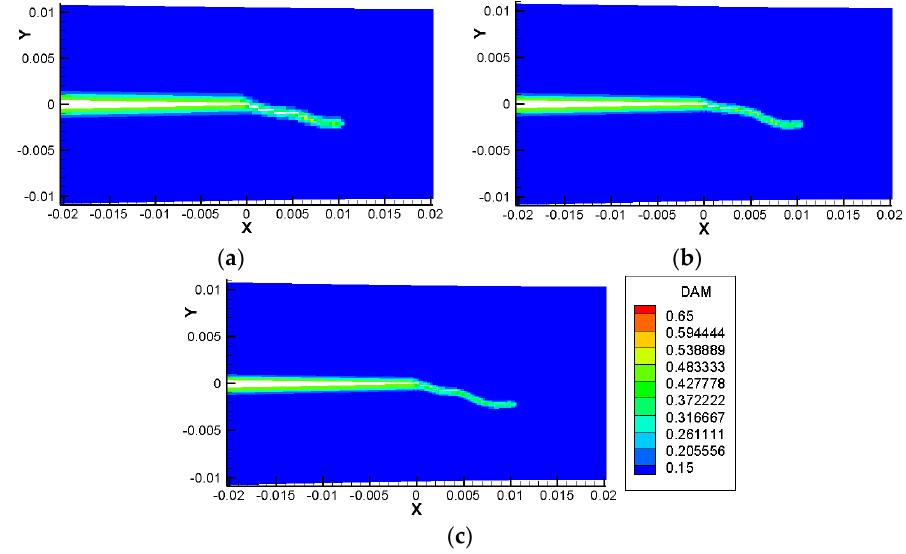
Figure 4. Crack path with different δ ( m = 4) values using peridynamics (PD) models at 80 µs. ( a ) δ =